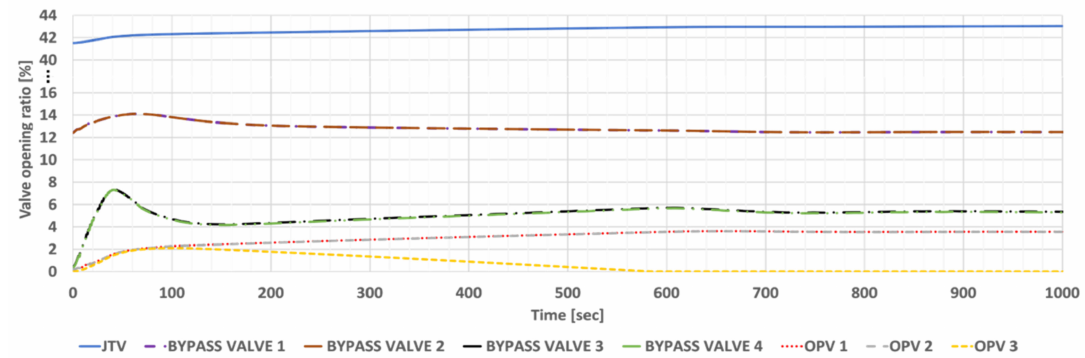
Figure 20. Valve opening ratio when two engines are tripped.